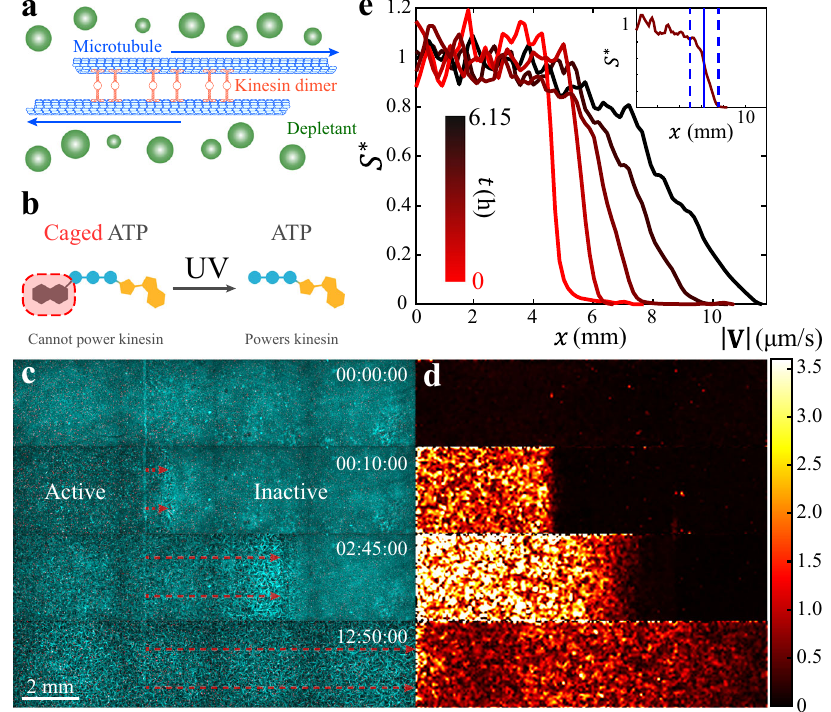
Fig. 1 | (Experimental results) Mixing of activated and inactive microtubule- kinesin fl uid. a Microscopic dynamics in microtubule-kinesin active fl uid. Deple- tants force microtubules into bundles where the microtubules can be bridged by kinesin motor dimers. The kinesin motors walk along the microtubules, forcing